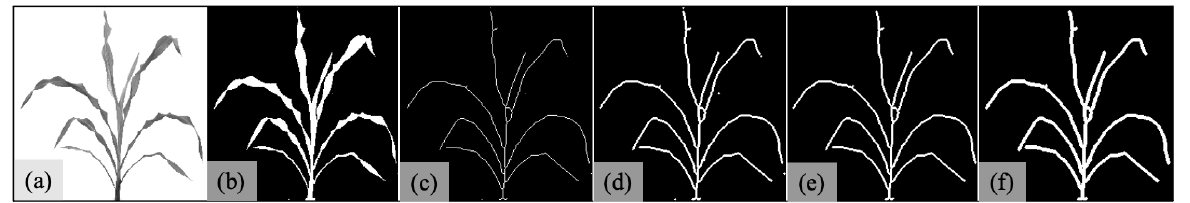
Figure 3. Skeleton structure steps: ( a ) gray-scale space image converted from Figure 2g; ( b ) binary image; ( c ) single-pixel wide skeleton image; ( d ) first dilation image; ( e ) small noises removed image; ( f ) second dilation